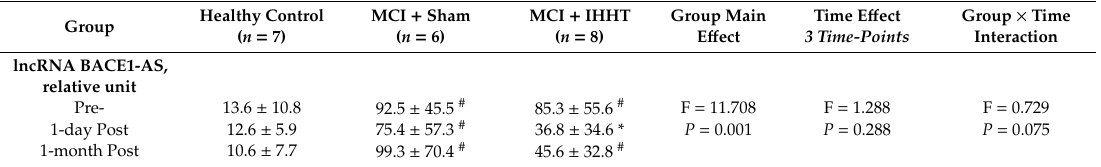
Table 4. Expression of lncRNA BACE-AS, the fast regulator of beta-site amyloid precursor protein cleaving enzyme (BACE1) under three-week sessions of sham training or IHHT. Healthy Control MCI + Sham MCI + IHHT Group Main Time E ff ect Group × Time Group 3 Time-Points ( n = 7) ( n = 6) ( n = 8) E ff ect Interaction lncRNA BACE1-AS, P = 0.075 relative unit Pre- 13.6 ± 10.8 92.5 ± 45.5 # F = 1.288 Data are mean ± SD and analyzed with two-way ANOVA with repeated measures. Abbreviations: MCI: mild cognitive impairment; IHHT: intermittent hypoxia-hyperoxia training; Pre: Pre-IHHT baseline; 1-day Post: One day after IHHT termination; 1-month Post: One month after IHHT